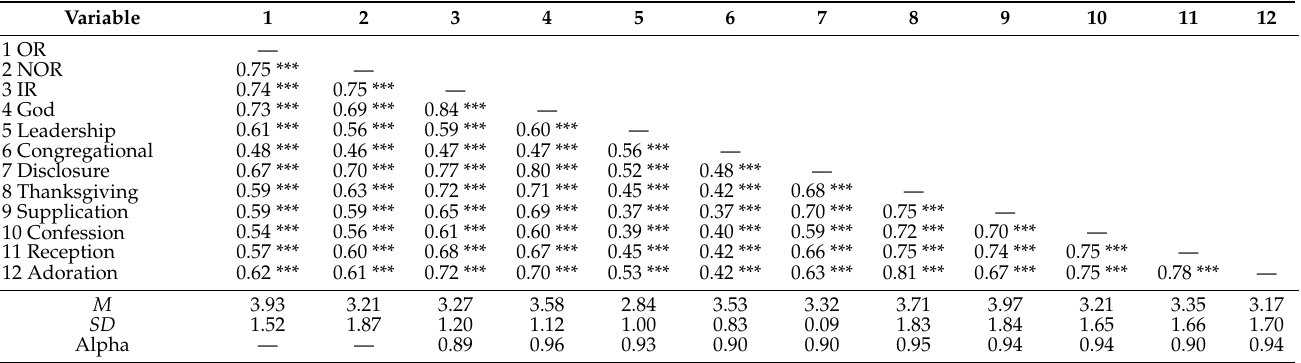
Table 4. Descriptive statistics and correlations between the MDI subscales and DUREL, RSS, and